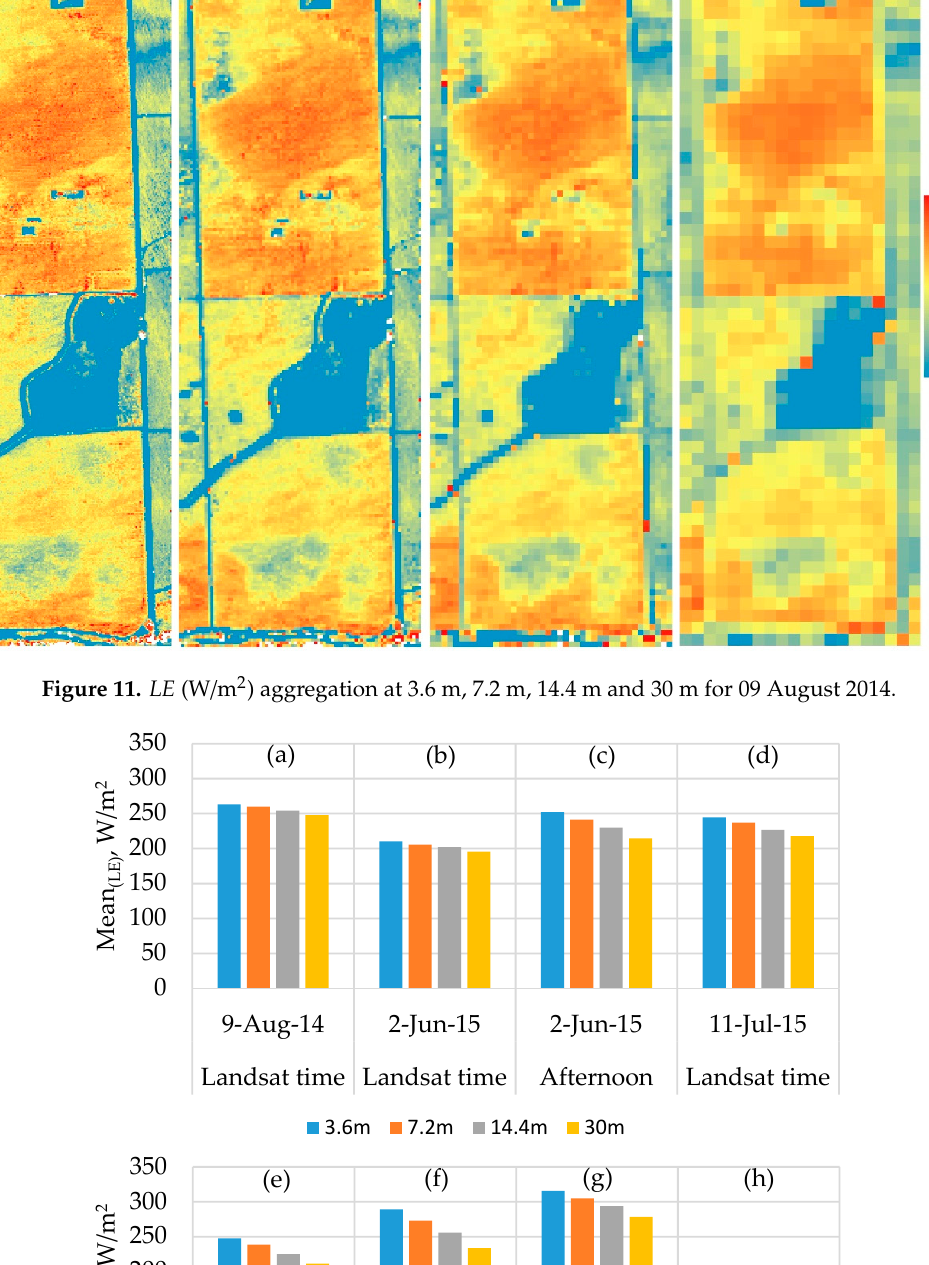
Figure 13. Spatial domain effect on the coefficient of variation ( CV ) of LE spatial data at different times.